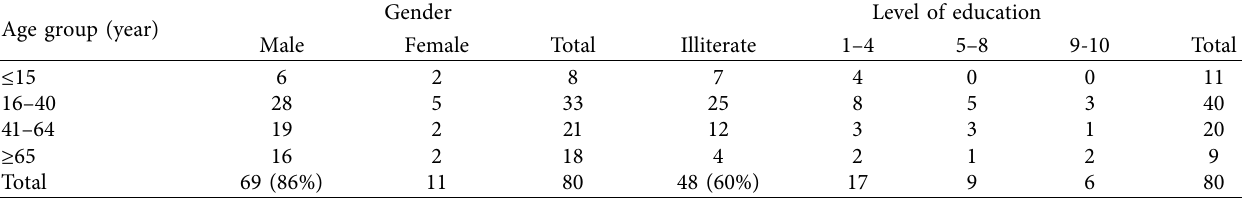
Table 1: Socioeconomic characteristics of the household respondents of the studied districts, South Omo Zone ( n � 80). Age group (year)